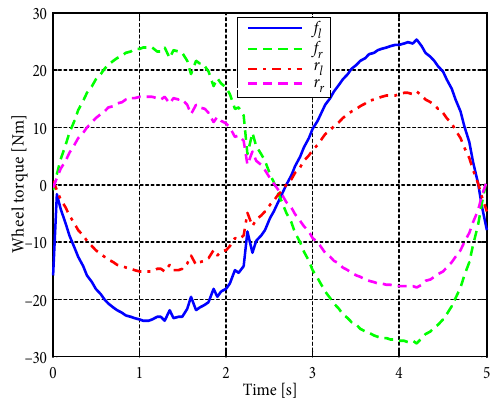
Fig. 11. Wheel torques (lane-change case)